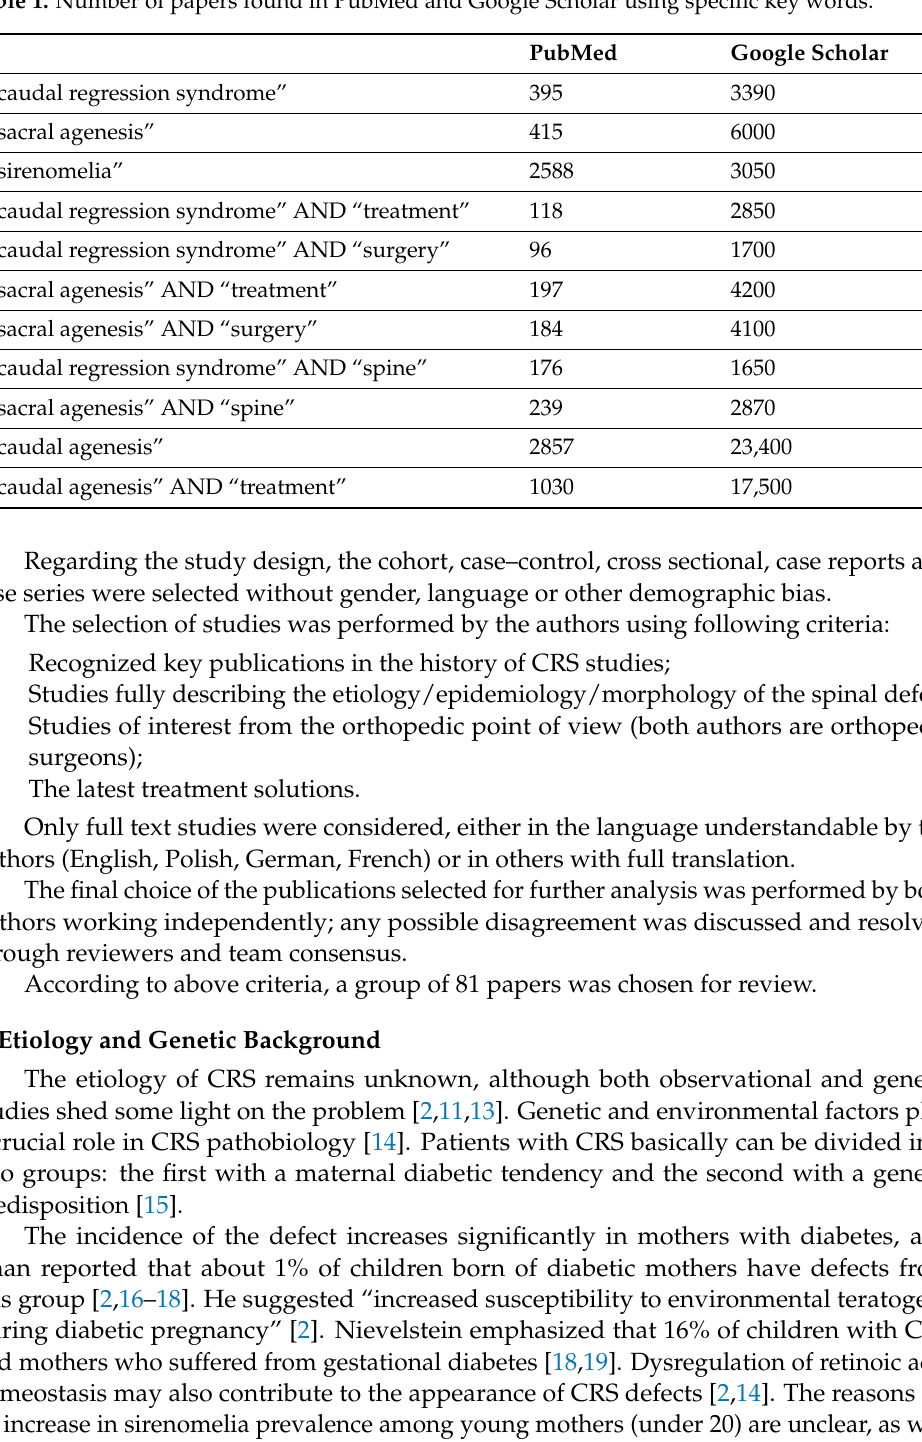
Table 1. Number of papers found in PubMed and Google Scholar using specific key